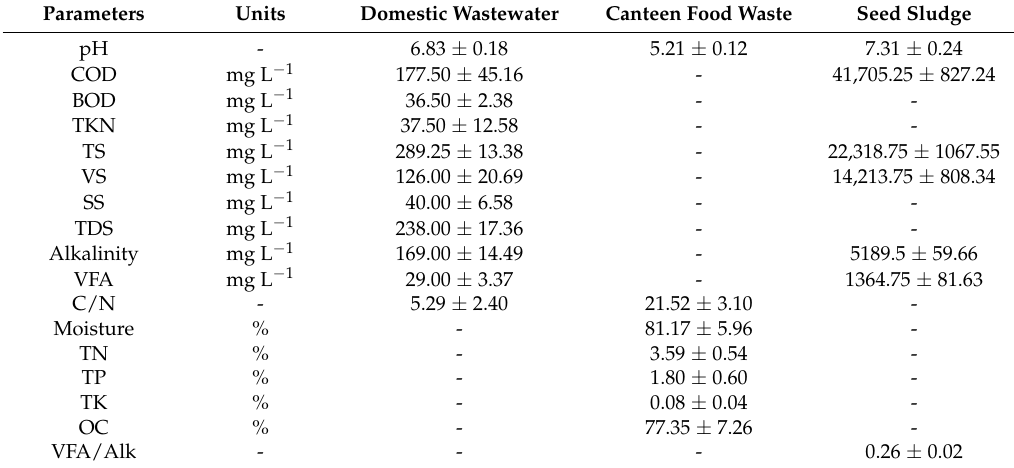
Table 1. Physicochemical properties of canteen food, domestic wastewater, and seed sludge (mean ± standard